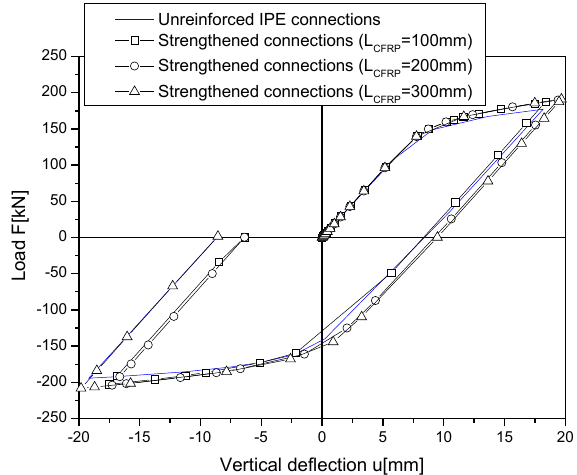
Figure 15. Force displacement curves for one loading cycle ( L CFRP = 100